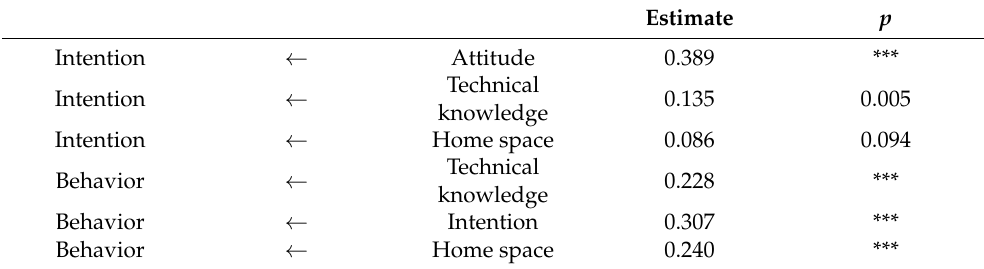
Table 6. Standardized regression weights (Group number 1, default model).